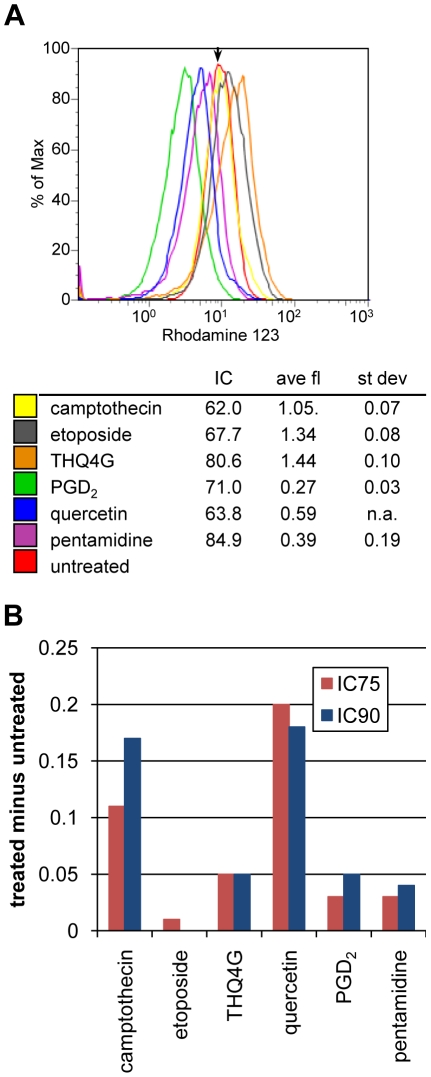
Assays of mitochondrial potential and generation of ROS in drug-treated parasites.A) Mitochondrial potential. After 24 hour drug treatment, parasites were incubated with rhodamine 123 and analyzed by flow cytometry. Dead cells, which were present in all samples, were excluded by gating on scatter. The arrow marks the midpoint for the untreated control. The legend includes the results from multiple experiments, showing the percentage decrease in number of live cells, average and standard deviation of rhodamine 123 fluorescence expressed as the ratio of the geometric means of the treated samples versus the untreated sample. B) Generation of ROS. Amount of ROS above that seen in untreated cells following a two-hour exposure to the indicated drugs at two different concentrations (see Table 1). ROS were assayed by flow cytometric detection of oxidized CM-H2DCFDA.